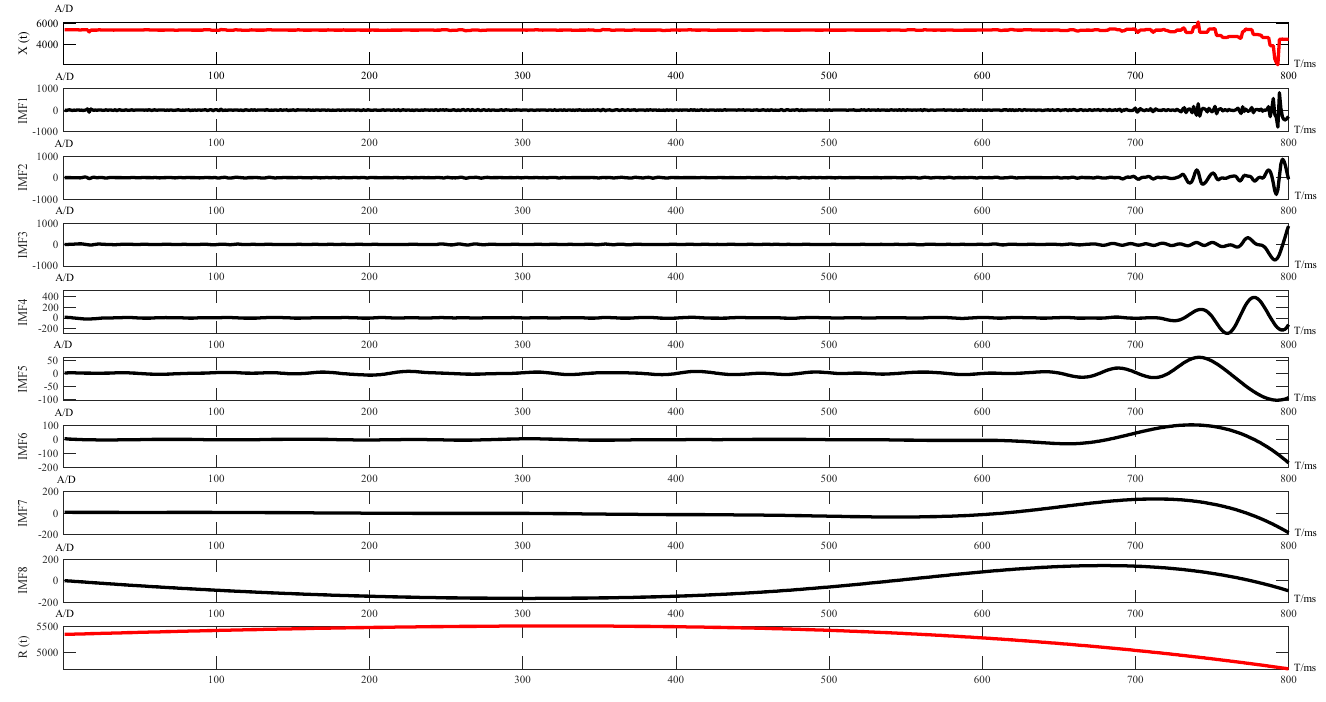
Figure 14. The decomposition diagram of EEMD.